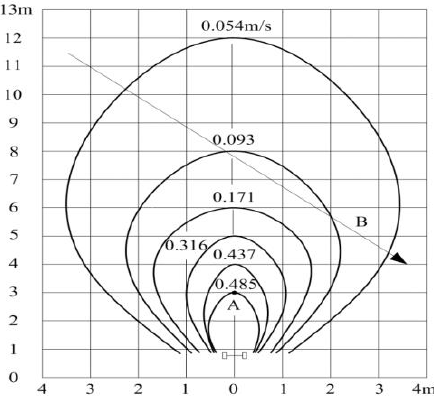
Figure 4. Magnitude of ocean current.